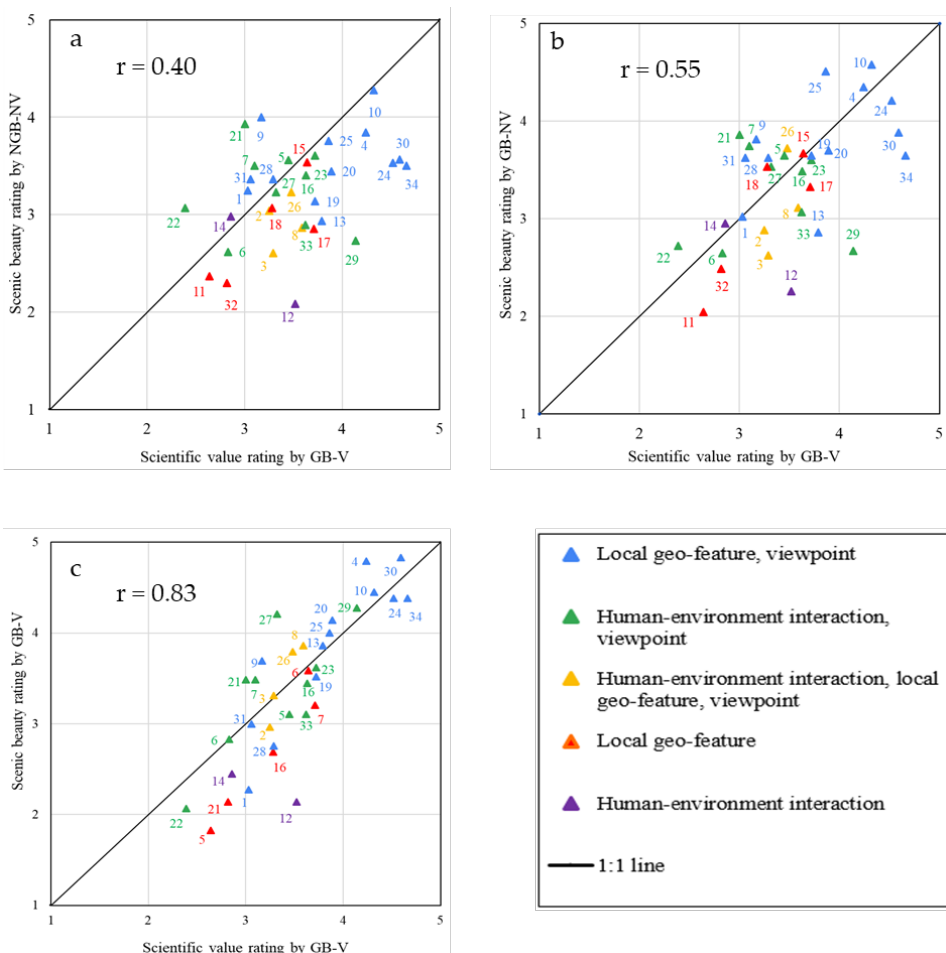
geosites; GB-V = geoscience background and visit to geosites) and scientific value (rated by the